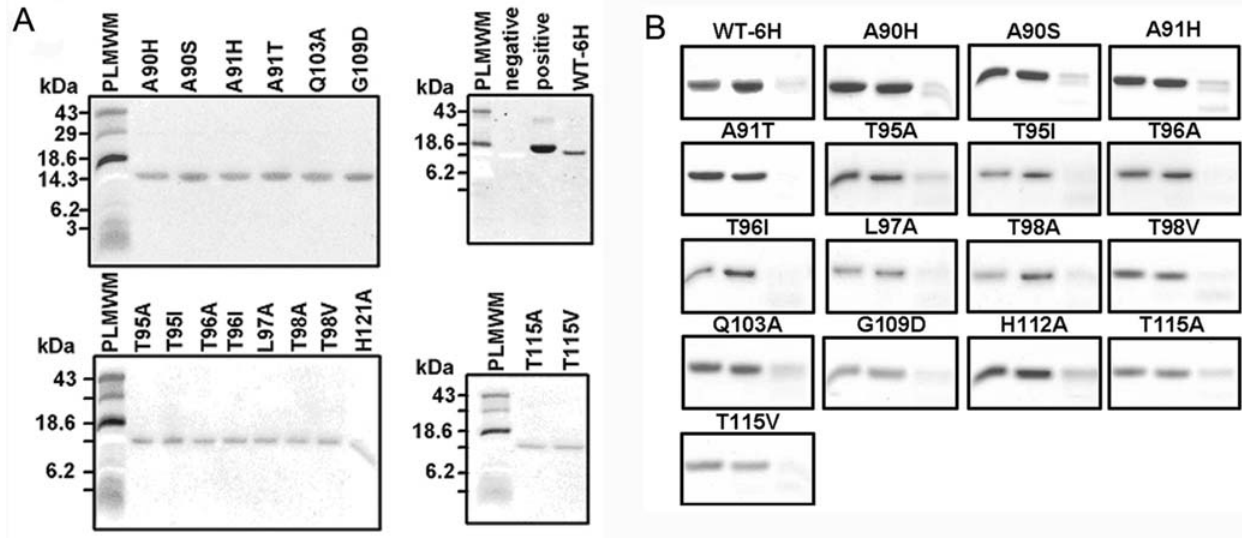
Figure 6. Ca 2 + -binding properties of hAFP and its mutants. (A) 45 CaCl 2 overlay assay of WT-6H and its mutants. Lysozyme was used as negative control and b -lactoglobulin was used as positive control. PLMWM represents prestained low molecular weight marker. Both wild-type hAFP and its mutants can bind Ca 2 + ions properly. (B) Proteolysis protection assay of WT-6H and its mutants. Endoprotease Glu-C was used to detect conformational changes of hAFP and its mutants as modulated by Ca 2 + ions. In the absence of Ca 2 + ions, hAFPs were subjected to Glu-C cleavage. Three lanes of each sample from left to right represent hAFP, and hAFP treated with Glu-C, respectively, in the presence, and in the absence, of Ca 2 + ions.